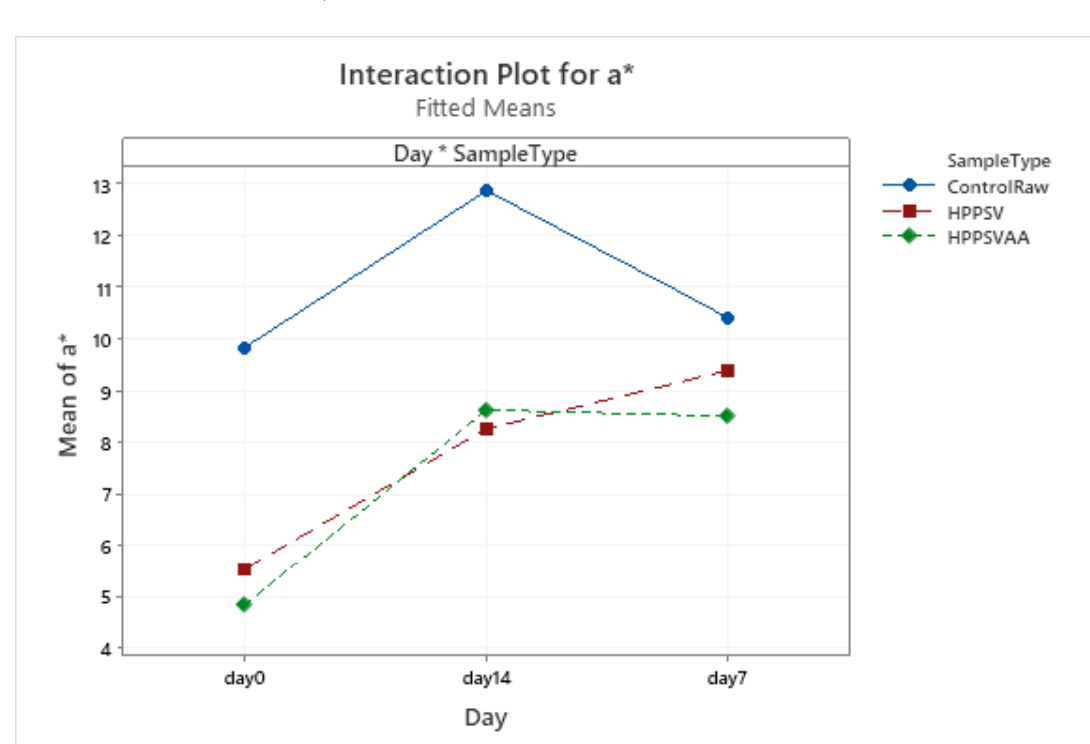
Figure A13. Effect of treatments and storage time on the L * coordinate of veal patty (HPPSV: HPP- SVCOOK).